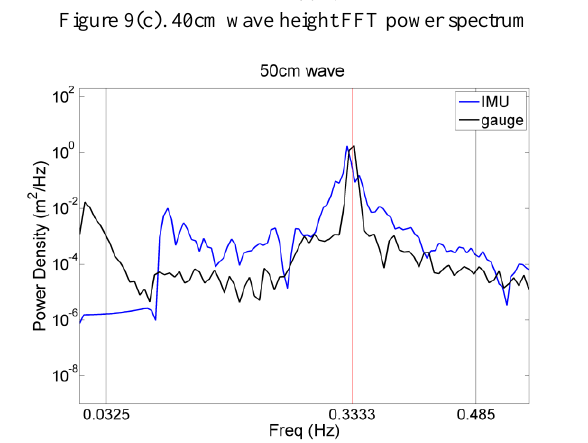
Figure 9(d). 50cm wave height FFT power